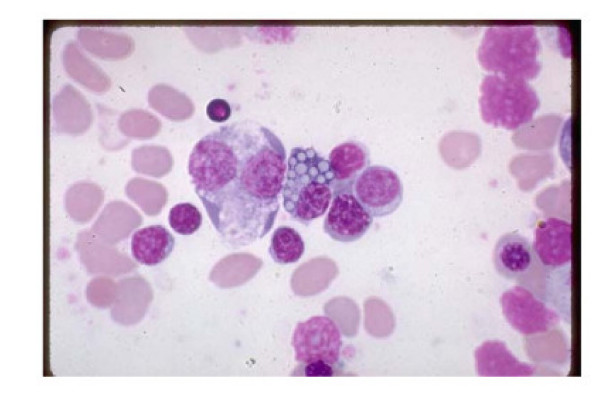
Bone marrow biopsy.